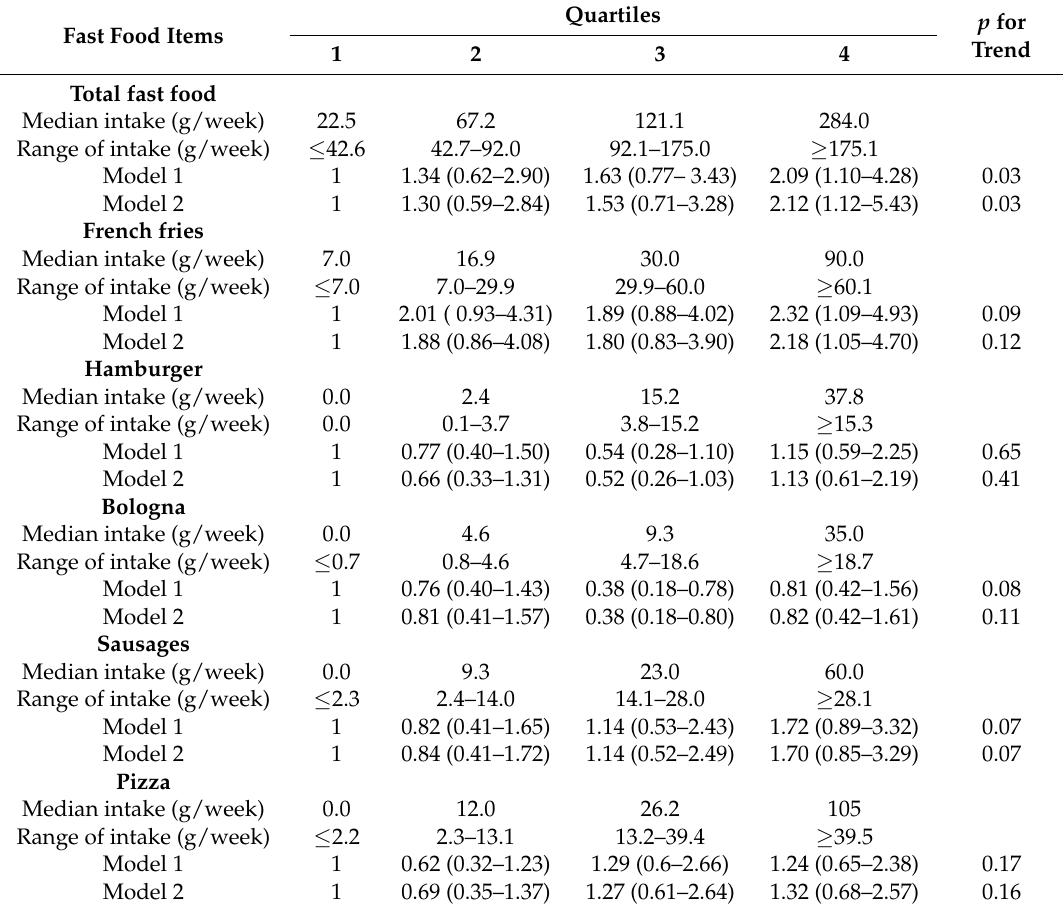
Table 3. Multivariate adjusted odds ratio (95% CI) for GDM across quartiles of fast food